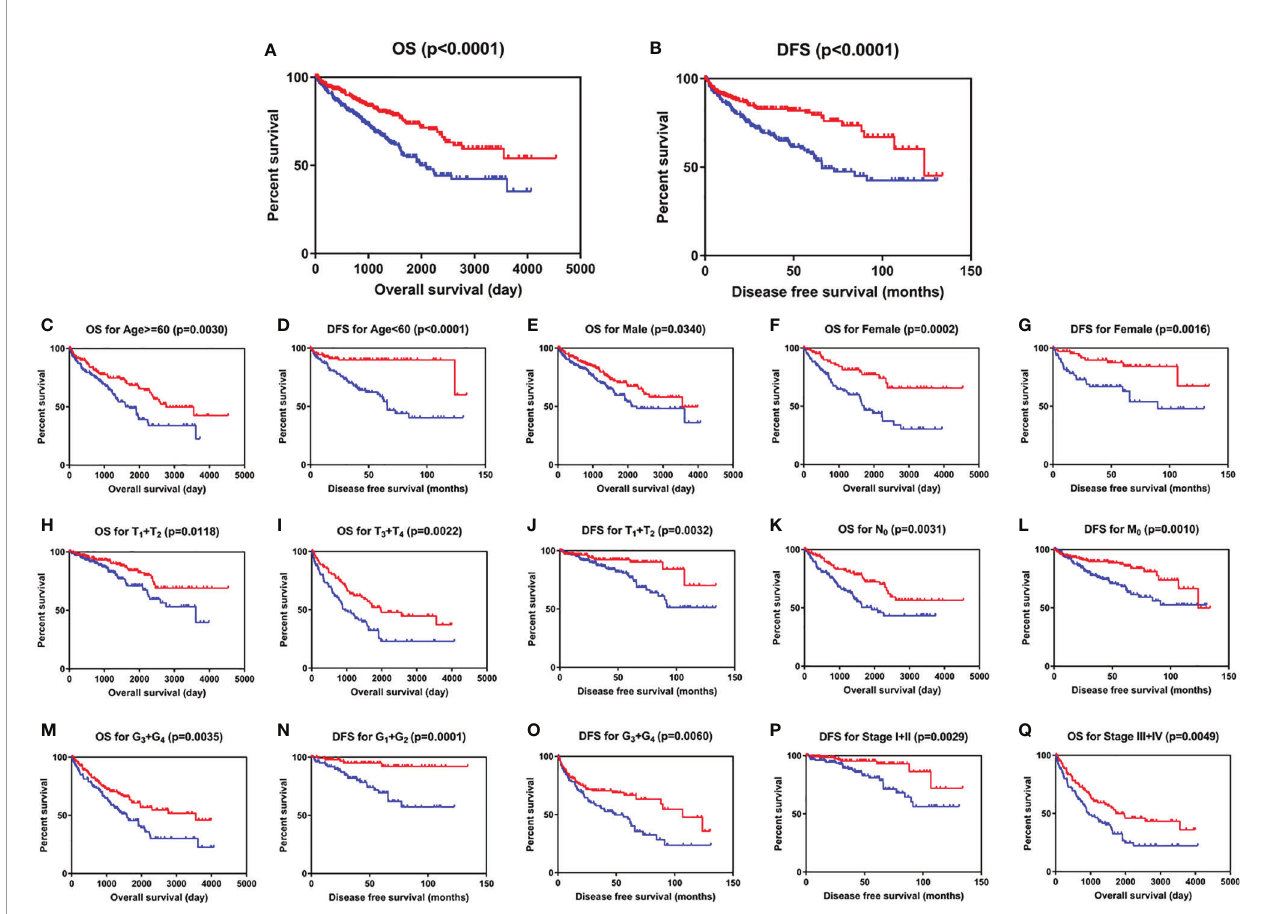
FIGURE 3 | Low SLC22A12 mRNA expression is associated with both poor OS and DFS in patients with ccRCC. Patients with lower SLC22A12 mRNA expression levels harbor worse (A) OS and (B) DFS. The similar results were obtained from (C – Q) subgroup of patients with